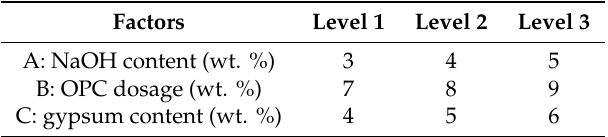
Table 3. Factor level table of orthogonal test.